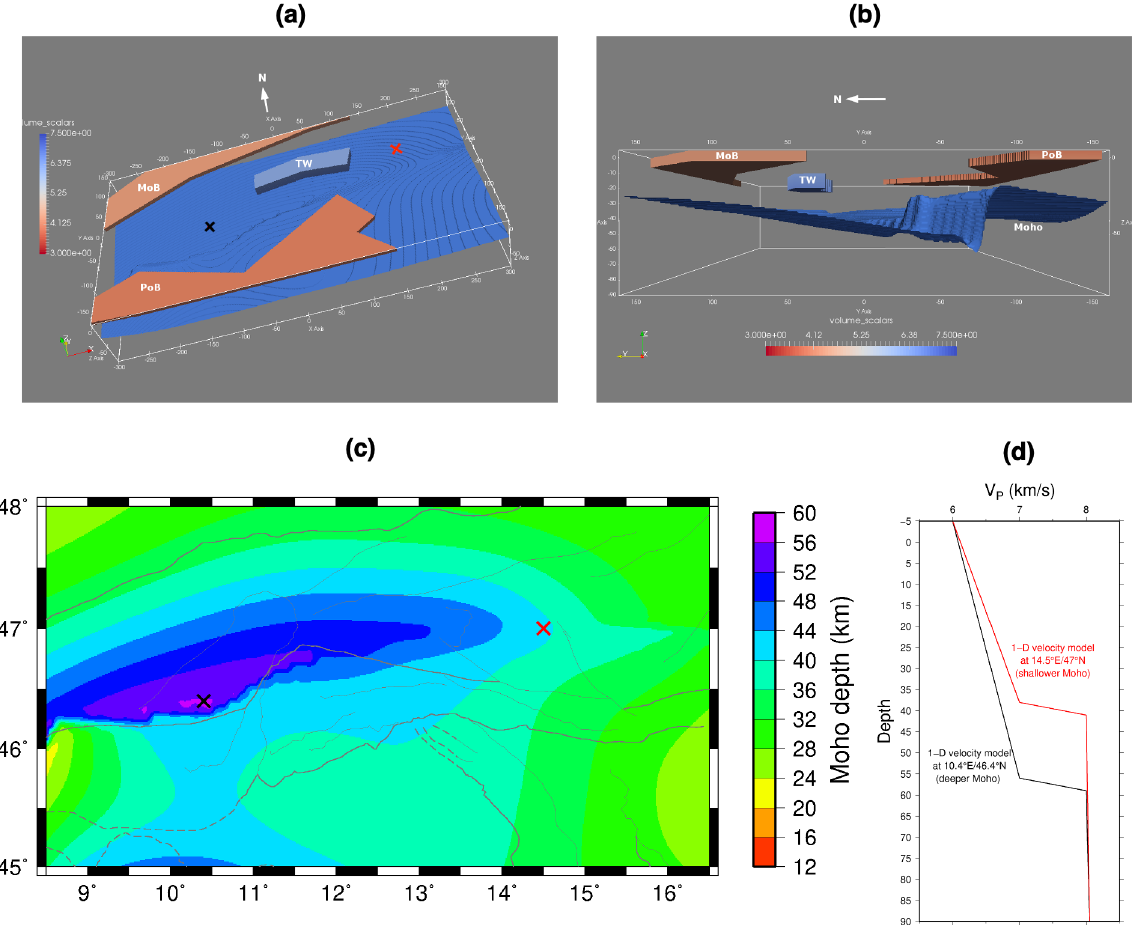
√ Figure 5. The 3-D synthetic V P velocity model. The V P /V S ratio was fixed to 3 in the entire model. (a) and (b) Contours of the Moho and shallow anomalies of the PoB, MoB, and TW from different view directions. (c) Modified Moho depth map based on Spada et al. (2013). (d) A 1-D velocity model of two different locations with shallower and deeper Moho retrieved from the 3-D synthetic velocity model (the locations are shown with red and black crosses in (a) and (c) , respectively). The faults are the same as those in Fig.